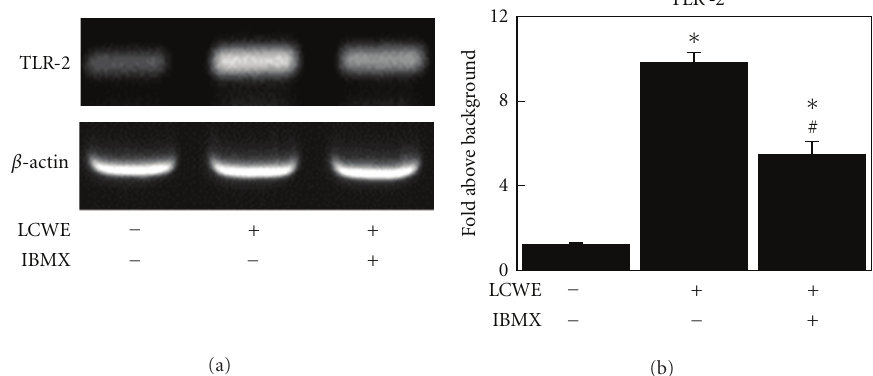
Figure 4: Change in the expression of TRL-2 (a, b) in NIH3T3 mouse fibroblast cells after treatment with LCWE (10 μ g/mL) or a com- bination of IBMX (1 μ M) and LCWE (10 μ g/mL). Each column represents the mean ± SEM. ∗ P < 0 . 01 versus untreated controls. # P < 0 . 01 versus LCWE treatment